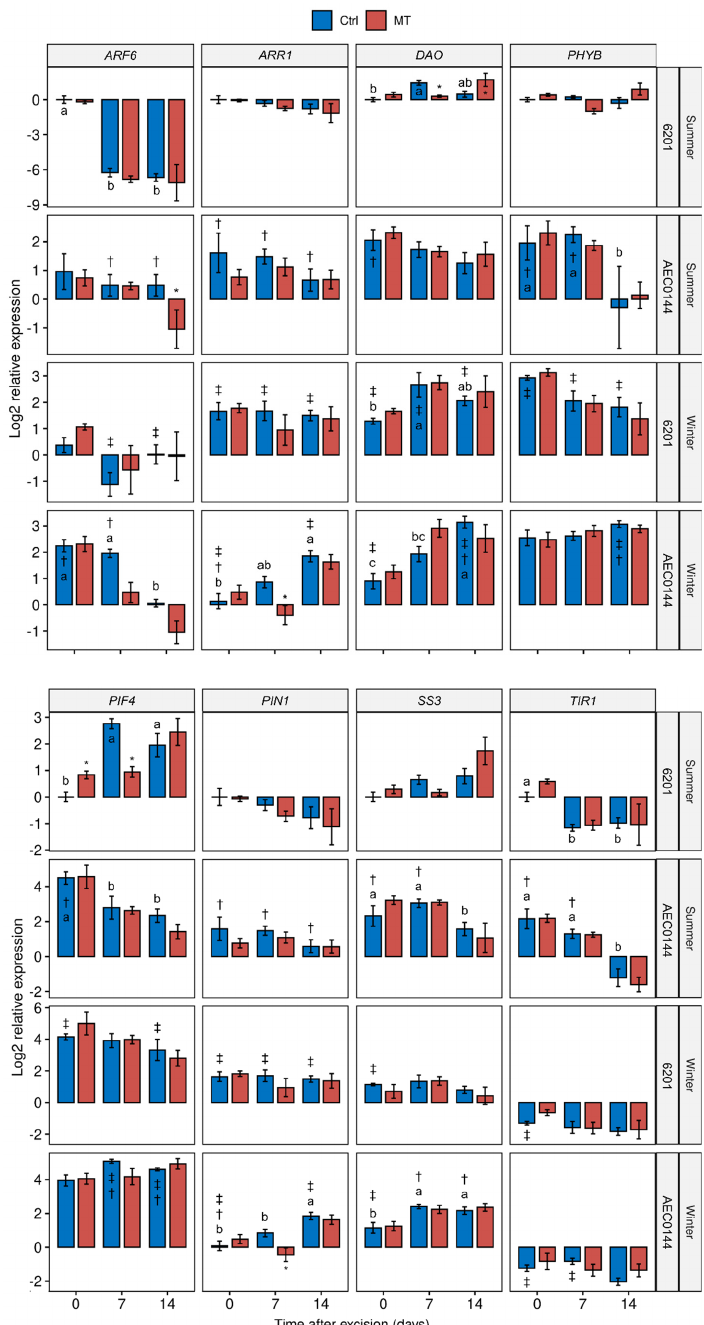
Figure 5. Transcriptional profiles of E. dunnii 6201 (hardR) and E. × urograndis AEC0144 (easyR) cuttings. Log 2 -transformed RT-qPCR relative expression levels in whole cuttings at 0, 7, and 14 days post-excision from mini-stumps under control (Ctrl) and mini-tunnel (MT) conditions during summer and winter. Bars represent mean ± SEM ( n = 3). Asterisks (*), daggers (†), and double daggers (‡) indicate signi fi cant di ff erences between the Ctrl and treatments, between clones in comparison to the Ctrl, and between seasons in comparison to the Ctrl, respectively. Different lowercase letters indicate Ctrl timewise variation (factorial ANOVA, estimated marginal means test, p ≤ 0.05).